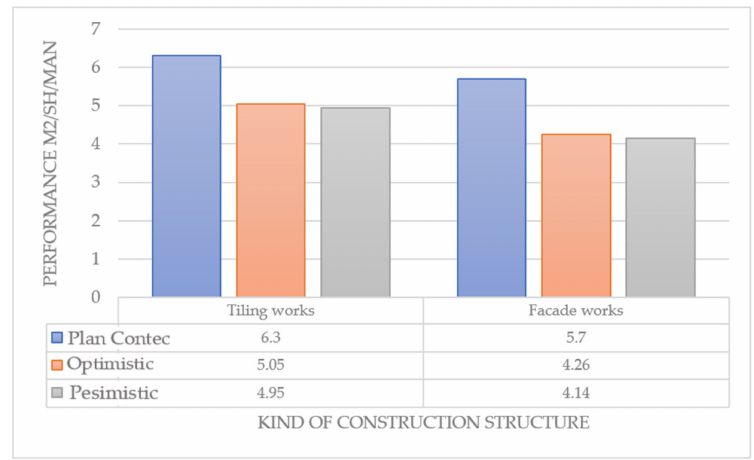
Figure 16. Productivity of tiling and façade